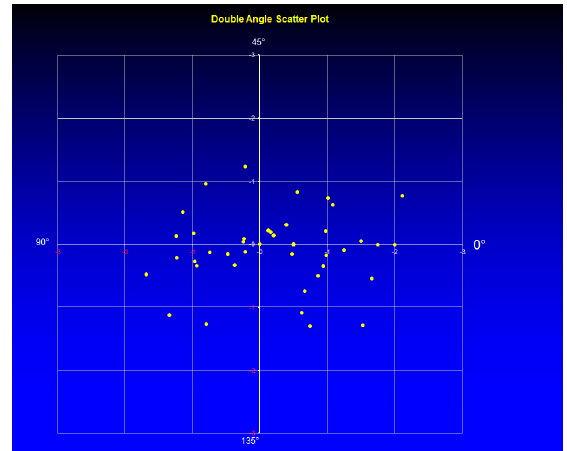
Figure 9. Double angle scatter plot for group 2.